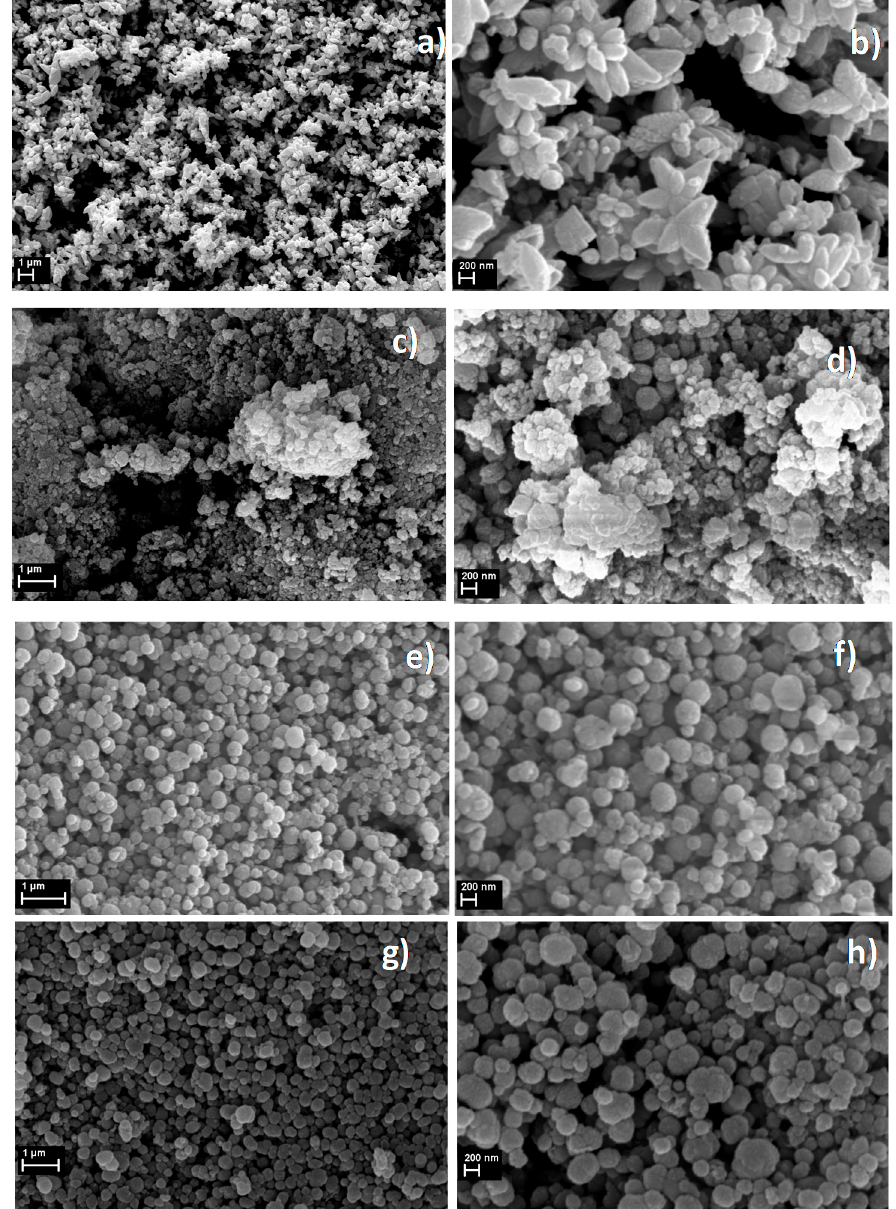
Figure 2. SEM images at two magnifications of samples: ( a , b ) AgZnO-CUI; ( c , d ) ZnO-CUI; ( e , f ) AgZnO-MAND and ( g , h ) ZnO-MAND.